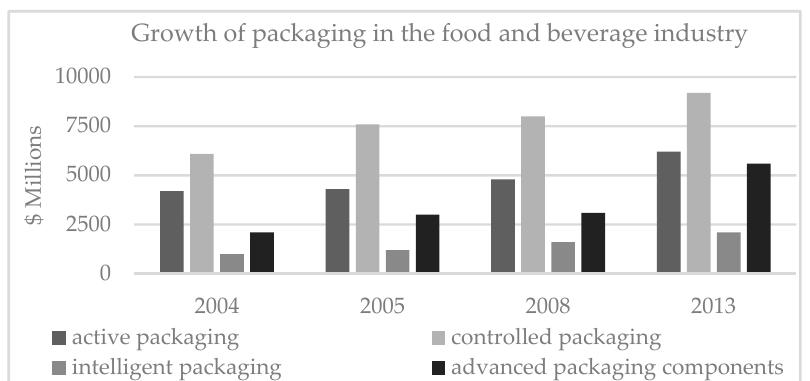
Figure 8. Growth of active, controlled, and intelligent packaging for the food and beverage industry 2004–2013 ($ millions), adapted from